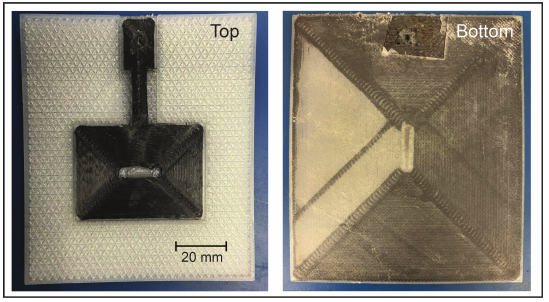
Figure 14. Fabricated AM patch antenna with nylon substrate and carbon fiber patch. Table 6. Calculated and optimized dimensions by ANSYS electronic